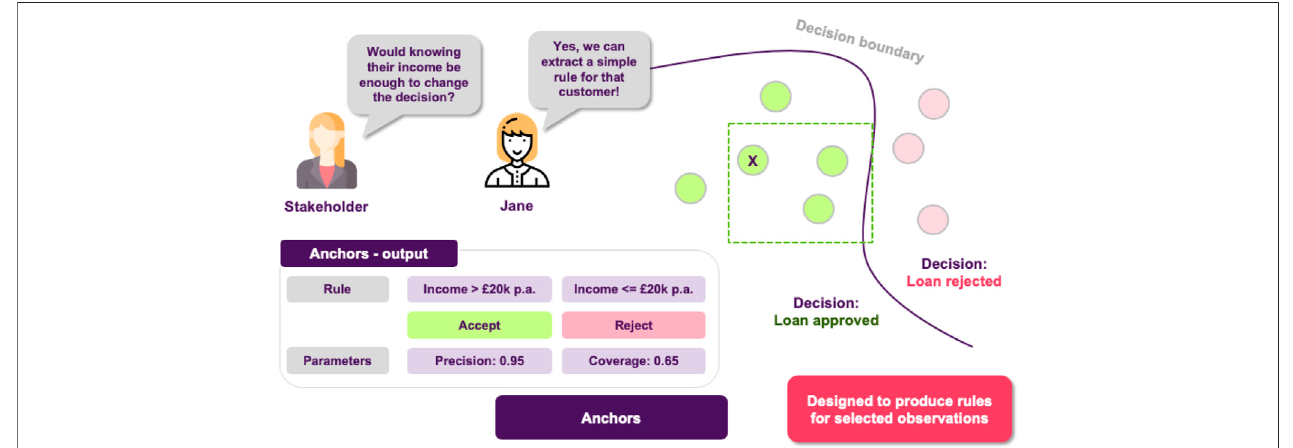
FIGURE 9 | Local explanations as rules. High precision means that the rule is robust and that similar instances will get the same outcome. High coverage means that large number of the points satisfy the rule ’ s premises, so the rule “ generalizes ” better.